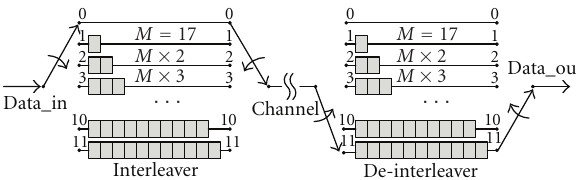
Figure 14: Convolutional interleaver and deinterleaver in DVB.